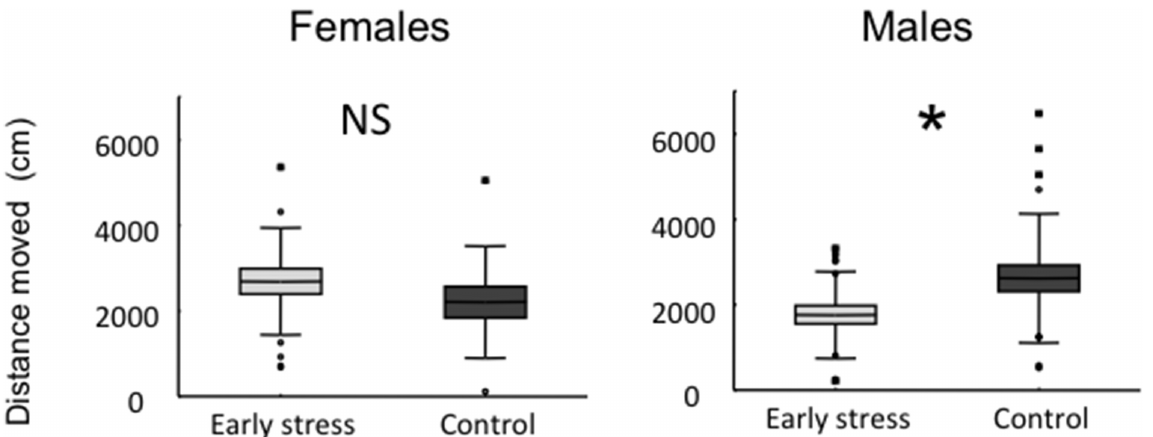
Fig 1. Box plots showing the Open Field activity for early stressed and control females (N = 29) and males (N = 44). The horizontal lines show average values, the boxes indicate standard errors, and the whiskers show standard deviation. Dots indicate outliers. A and B: Latency to leave the start zone (s); C and D: Total distance moved (cm). * : P < 0.05, NS = not